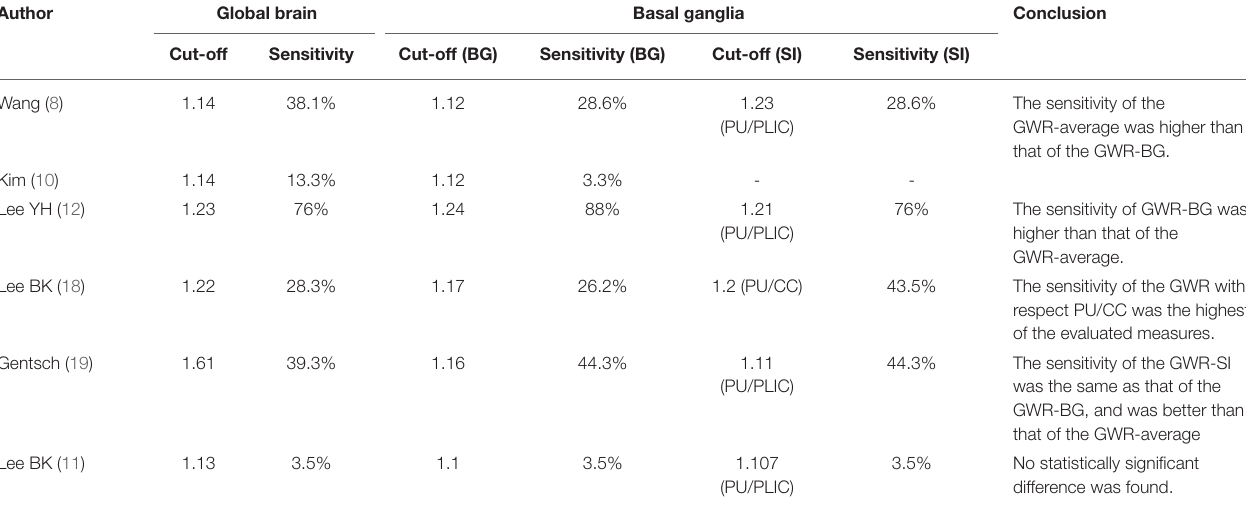
TABLE 3 | Comparison of the sensitivity between the average gray-white matter ratio (GWR-average) and the gray-white matter ratio at the basal ganglia (GWR-BG) in predicting poor neurologic outcomes in cardiac arrest survivors.